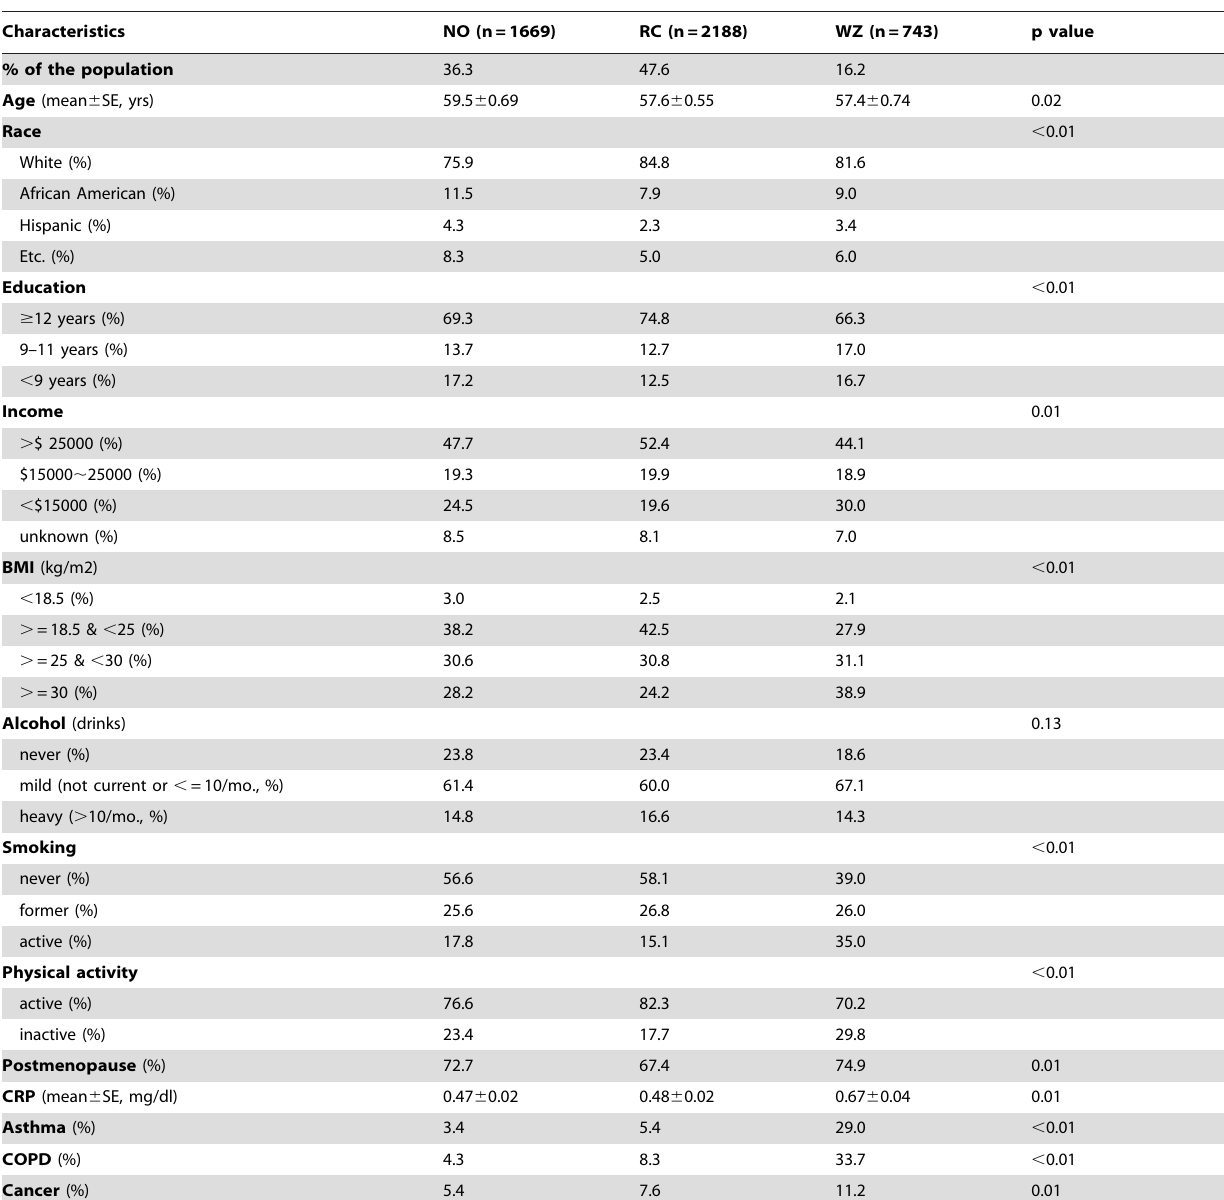
Table 1. Characteristics of study participants by allergic symptoms.